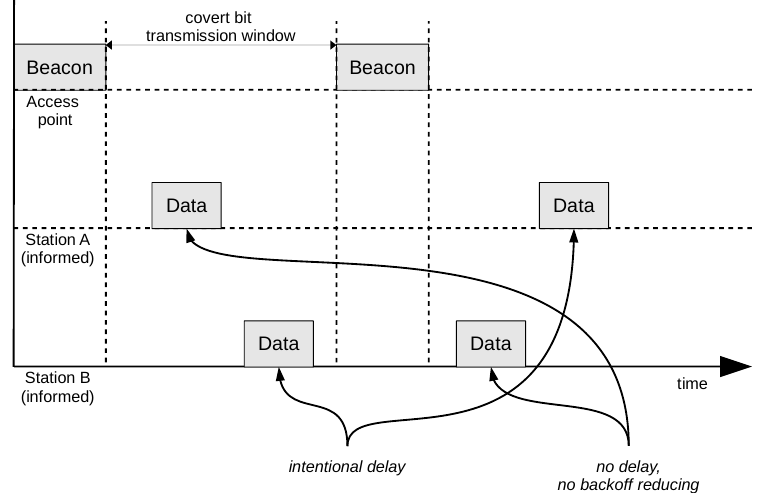
Figure 3. Both-informed variant of the SFO